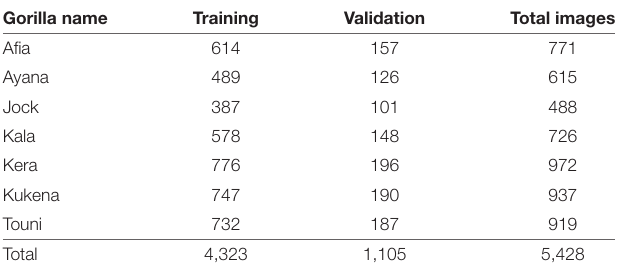
TABLE 2 | Complete